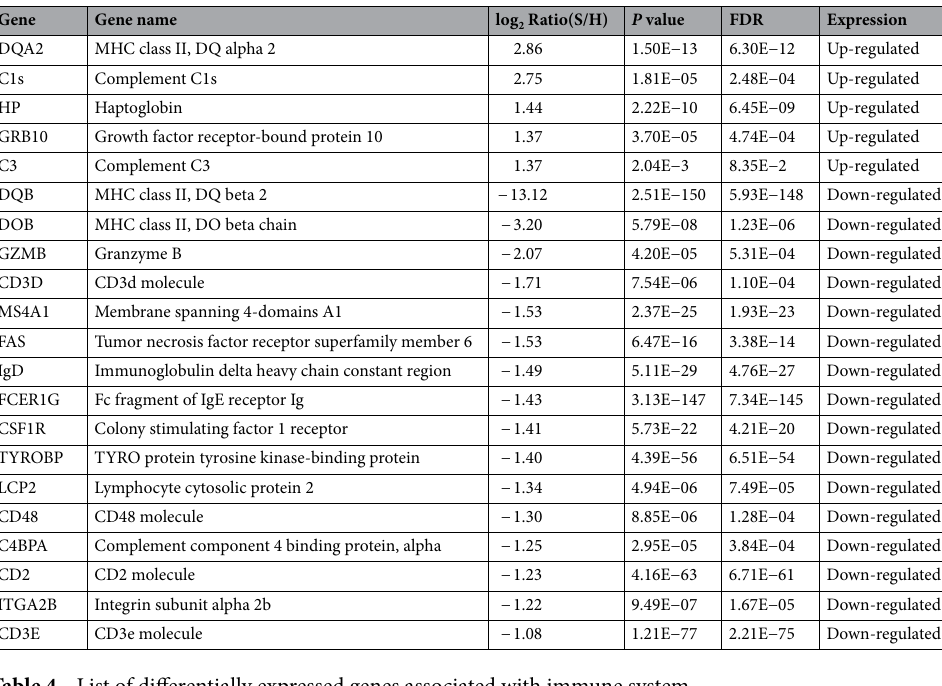
Table 4. List of differentially expressed genes associated with immune system.